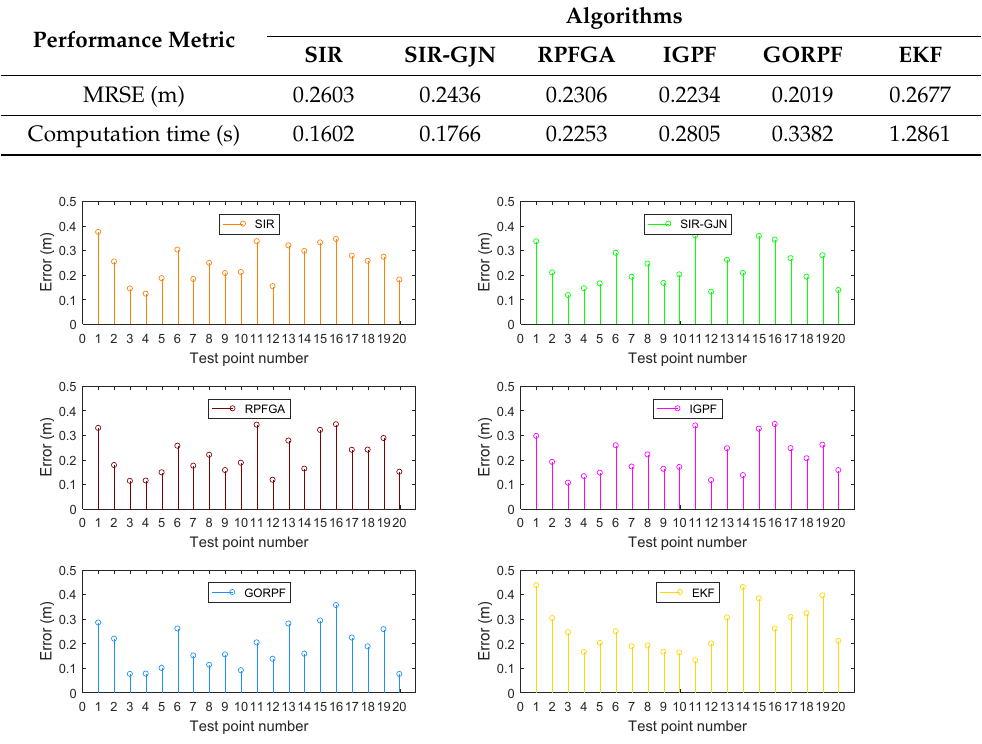
Table 5. The MRSEs (m) and computation time (s) of the six algorithms.